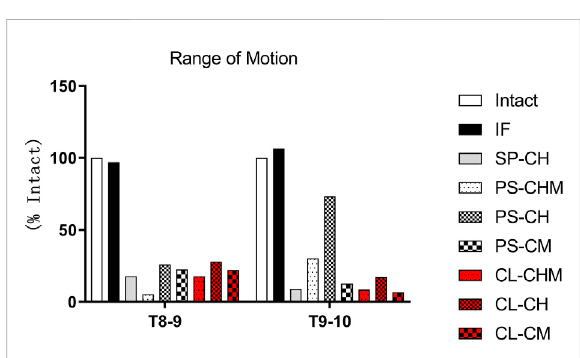
FIGURE 3 Range of motion (% ROM in model intact), measured at the T8 – 9 and T9 – 10 segments for model intact and IF, SP-CH, PS- CHM, PS-CH, PS-CM, CL-CHM, CL-CH, and CL-CM